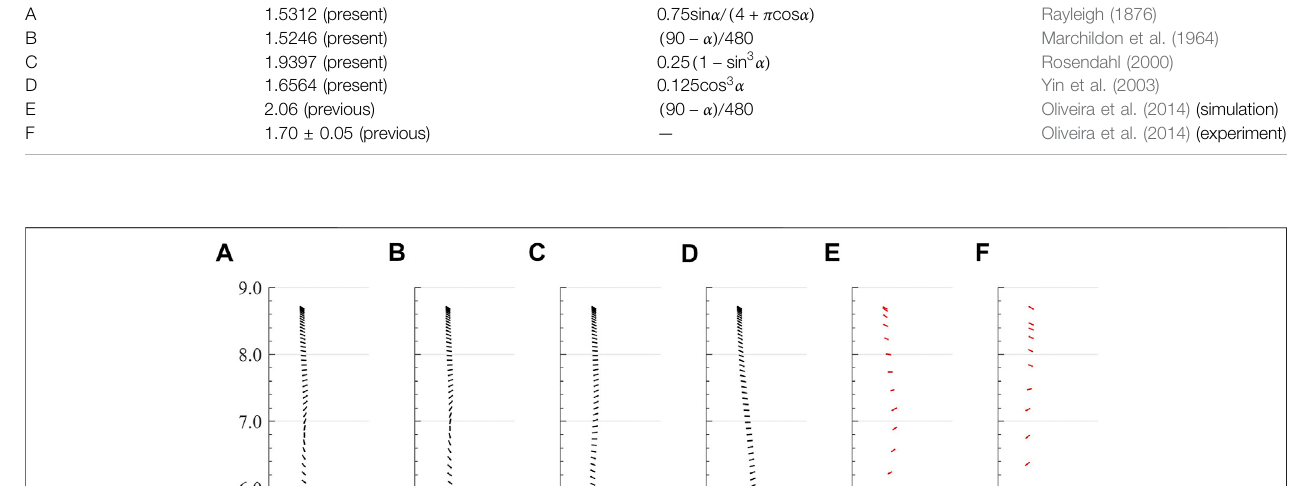
TABLE 1 | Landing time of a cylindrical fi rebrand released in a still air in the previous experiment and simulation (Oliveira et al., 2014), and present simulations using different formula for the center of pressure x cp (Rayleigh, 1876; Marchildon et al., 1964; Rosendahl, 2000; Yin et al., 2003). Landing time (s)